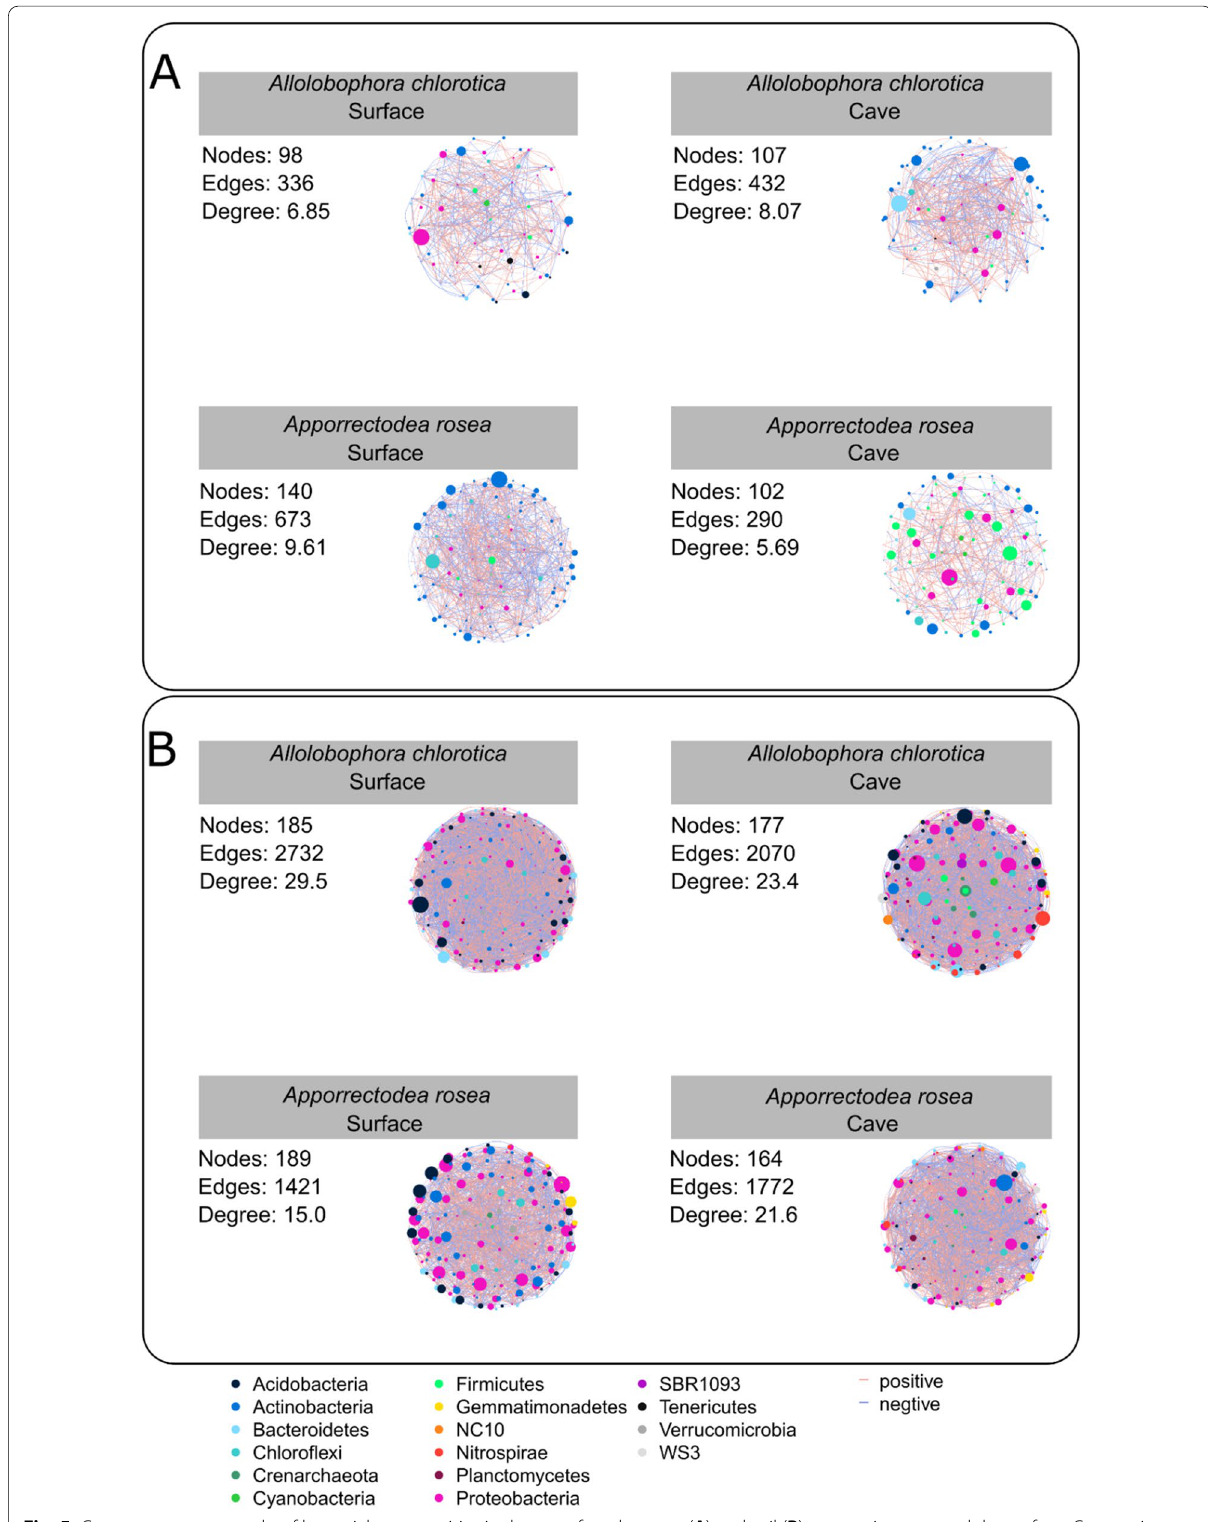
Fig. 5 Co‑occurrence networks of bacterial communities in the gut of earthworms ( A ) and soil ( B ) present in caves and the surface. Connections represent strong (R 2 0.7) and significant (P 0.01) correlations inferred by SparCC. The size of each node is proportional to the betweenness. Blue ≥ ≤ lines represent significant negative and red lines significant positive correlations. Node colors represent the OTU